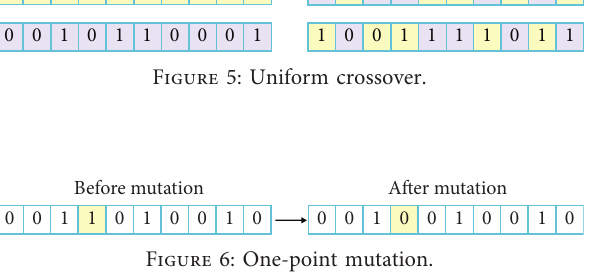
Figure 6: One-point mutation.